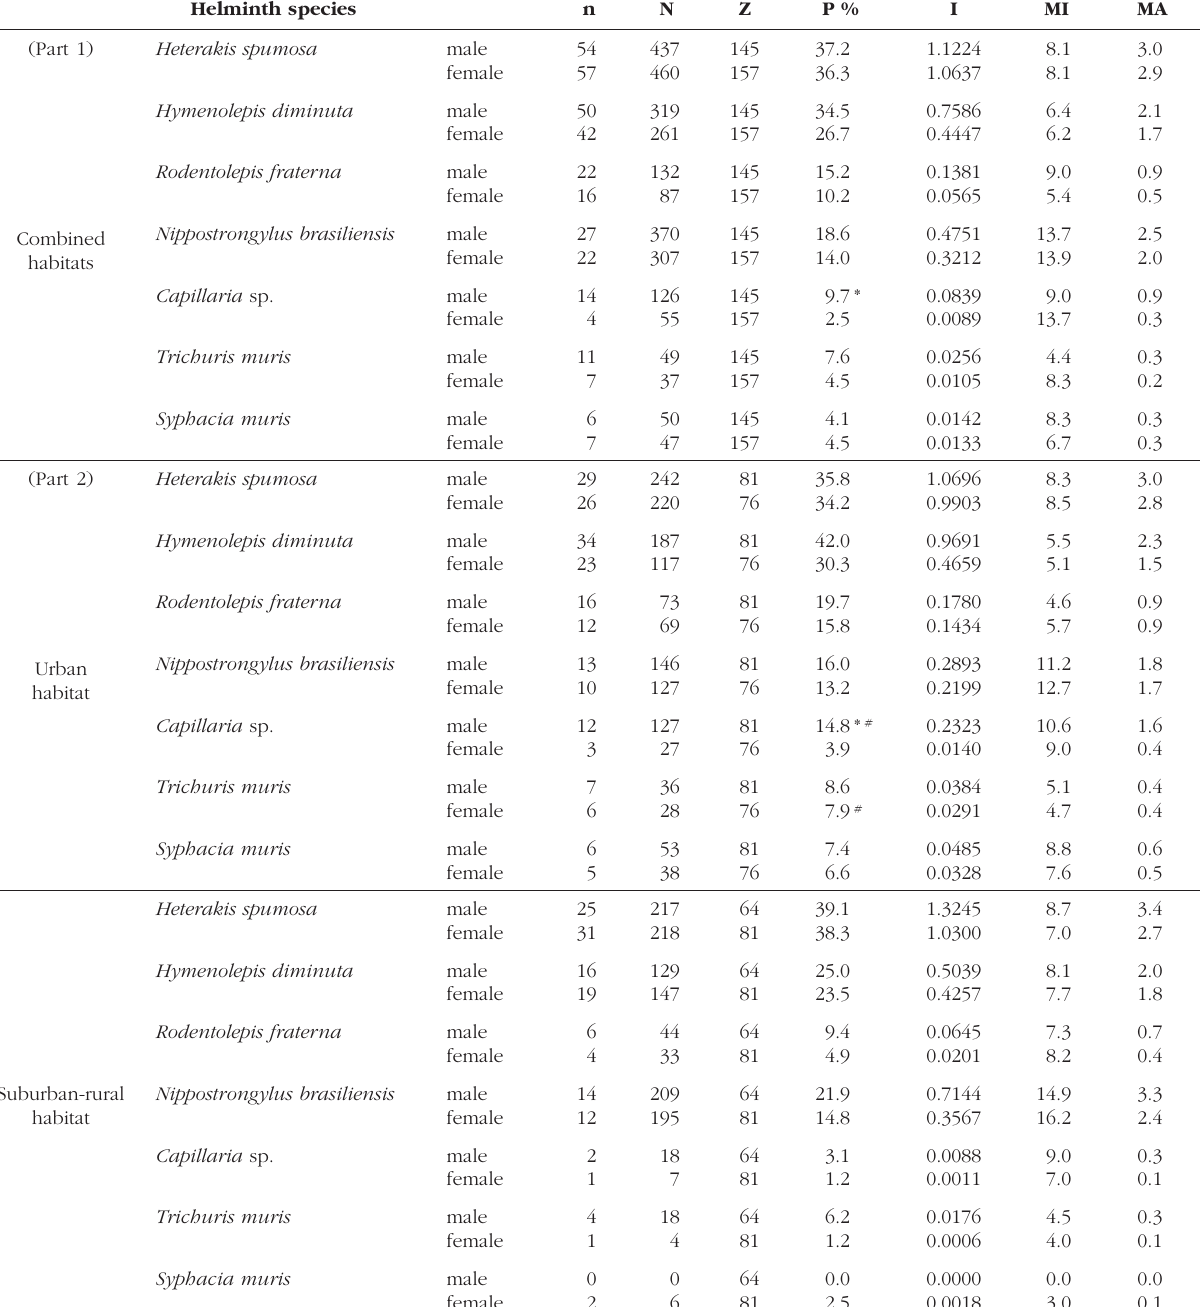
Table II. – Quantitative indices of individual intestinal helminth infections of Rattus norvegicus